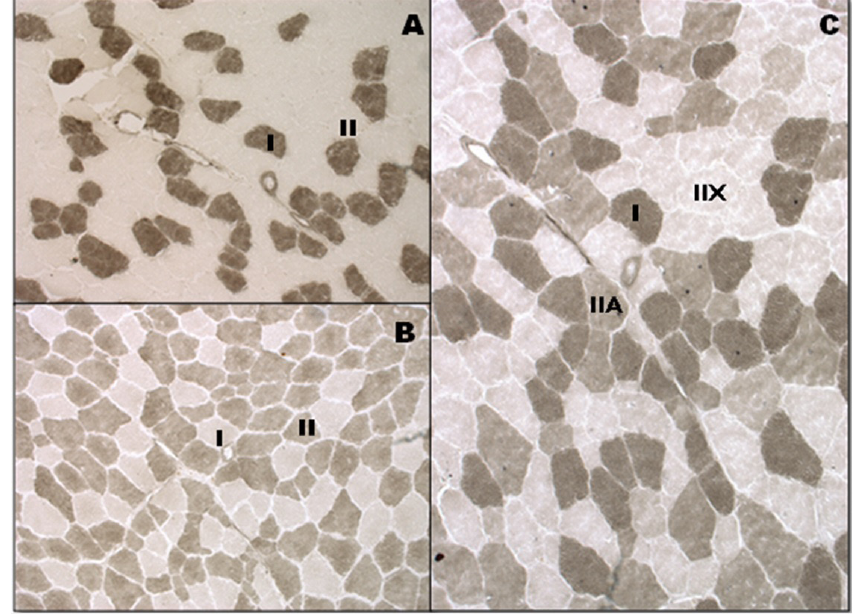
Figura 2. Fotomicrografia de cortes transversais seriados do músculo Glúteo Médio, utilizando-se a técnica de enzimo-histoquímica para marcação da ATPase miosínica (mATPase) com incubações em diferentes pH’s. (A) incubação ácida (pH 4.3), fibras do tipo I escuras e do tipo II claras; (B) incubação alcalina (pH 9.4), fibras do tipo I claras e do tipo II escuras; (C) incubação ácida (pH 4.6), fibras do tipo I escuras, fibras do tipo IIA com tonalidade intermediária e fibras do tipo IIX claras. Observar o padrão em mosaico das fibras. Animal: 07. Objetivas 20X (A, B); 40X (C).